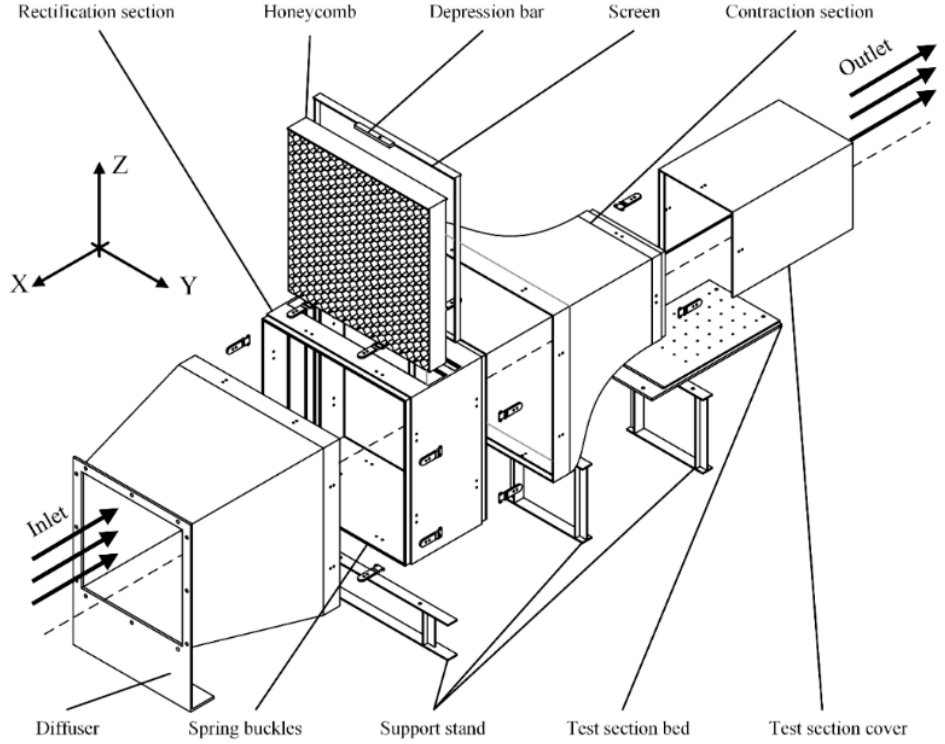
Figure 1. Structural diagram of the designed wind tunnel.